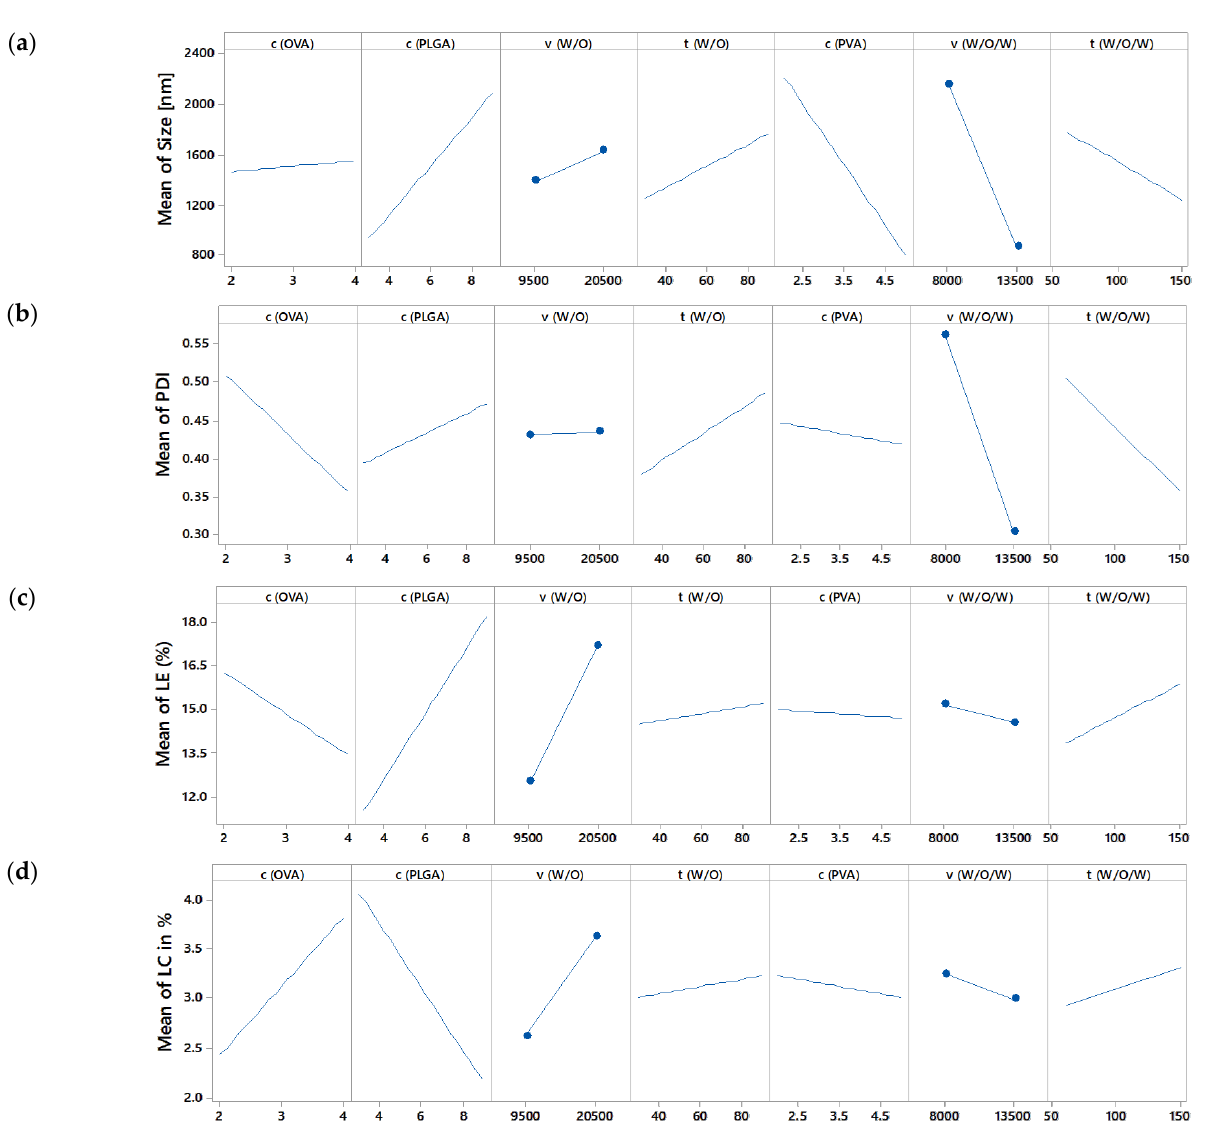
Figure 2. Main effects plots for z-average ( a ), PDI ( b ), loading efficiency ( c ) and drug load ( d ) .